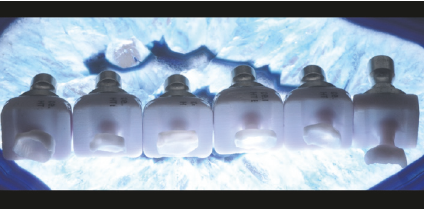
Figure 9: Intraoral scanning.